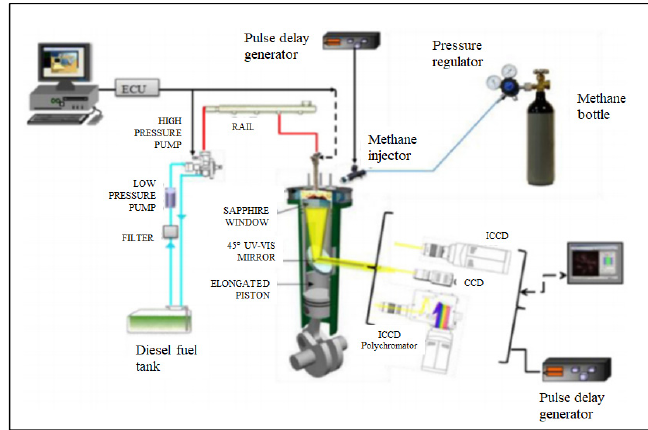
Figure 22. Experimental